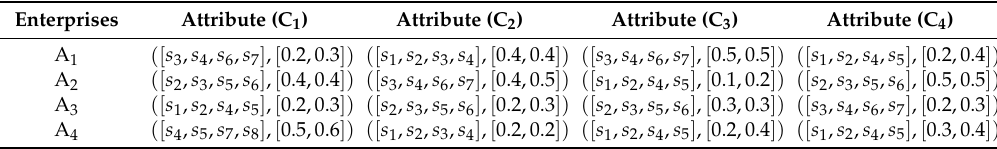
Table 1. The attribute values of each attribute with respect to four enterprises given by expert e 1 .